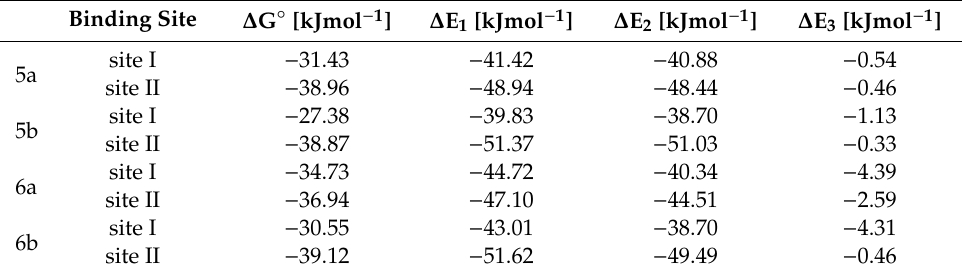
Table 6. Energies of the binding complexes BSA with 5a, 5b, 6a, and 6b obtained from molecular docking. Table6. EnergiesofthebindingcomplexesBSAwith 5a, 5b, 6a, and6b obtainedfrommoleculardocking.